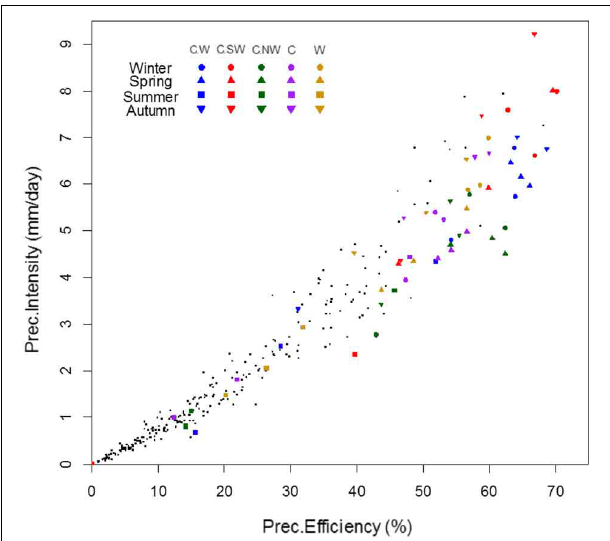
FIGURE 8 | Scatter plot between the Precipitation Intensity and the Precipitation Efficiency. Each point represents a single WT during a specific month (total of 26 × 12 = 312 points). R 2 of the linear fit is 0.94. The five WTs with the highest mean monthly Efficiency are highlighted in color, in order of decreasing Efficiency from left to right. For these five WTs, the three winter months (D-J-F) are shown as circles, the three spring